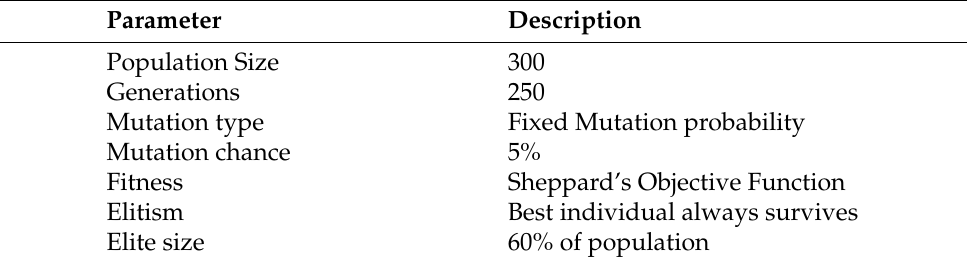
Table 5. Genetic parameters used in the experiments.